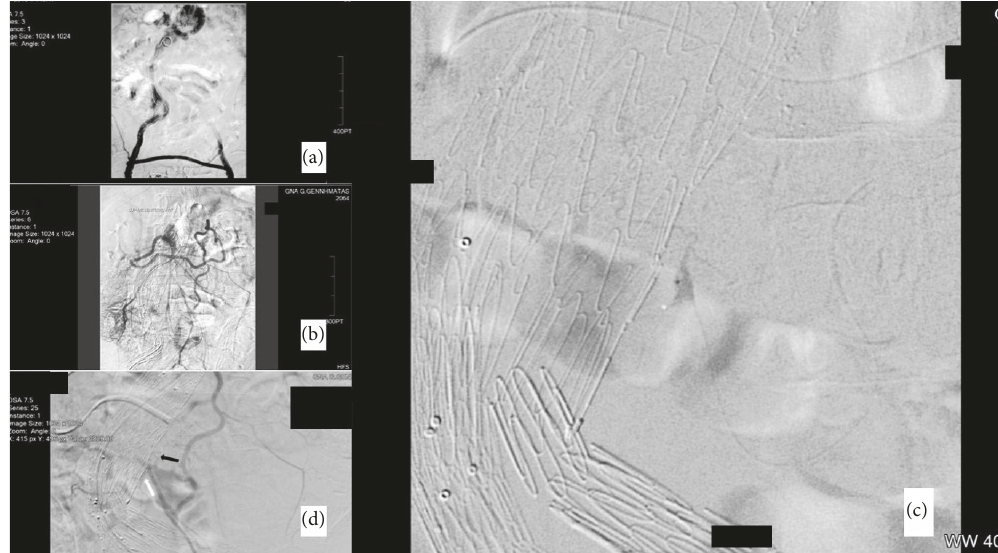
Figure 2: DSA angiography showing (a) antegrade flow through the aortounilateral stent graft and femorofemoral right to left bypass without Type I or III endoleaks, (b) the SMA and Riolano’s collateral arch (c) infusion from the microcatheter which revealed blush from an “unusual” collateral, and (d) exclusion of endoleak (black arrow) using Onyx R with protection of vital collaterals (white arrow).